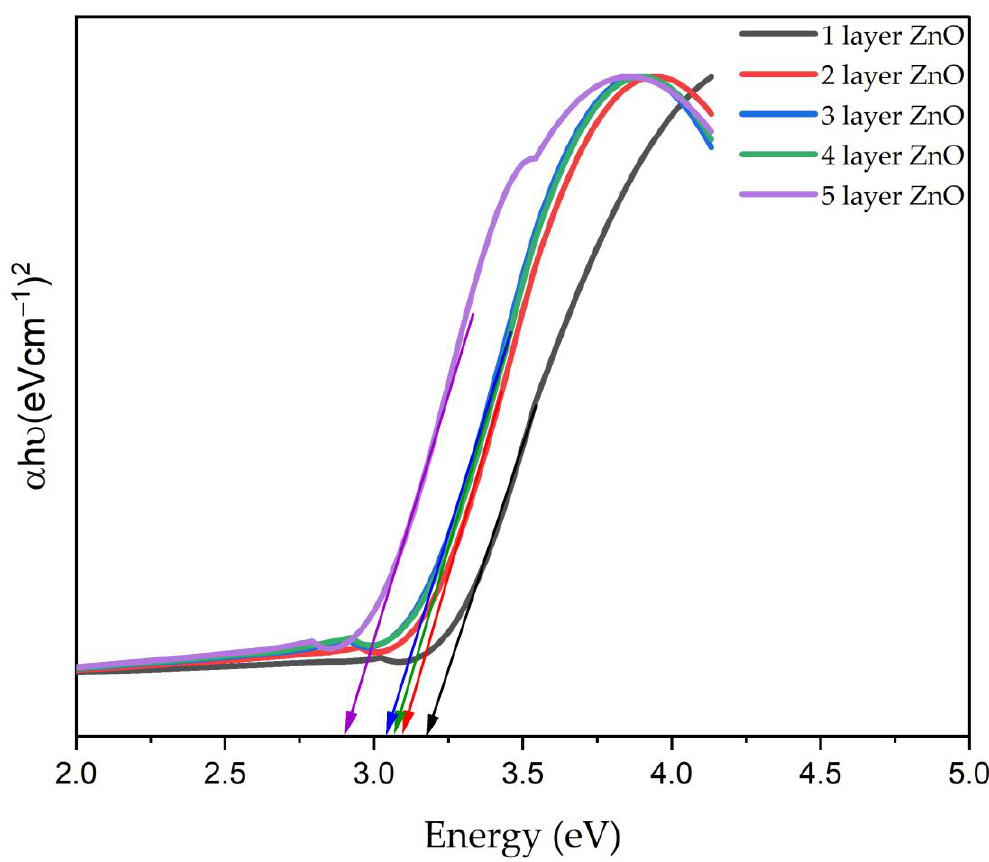
Figure 7. Tauc plot of the different thicknesses of ZnO film layers without dye.